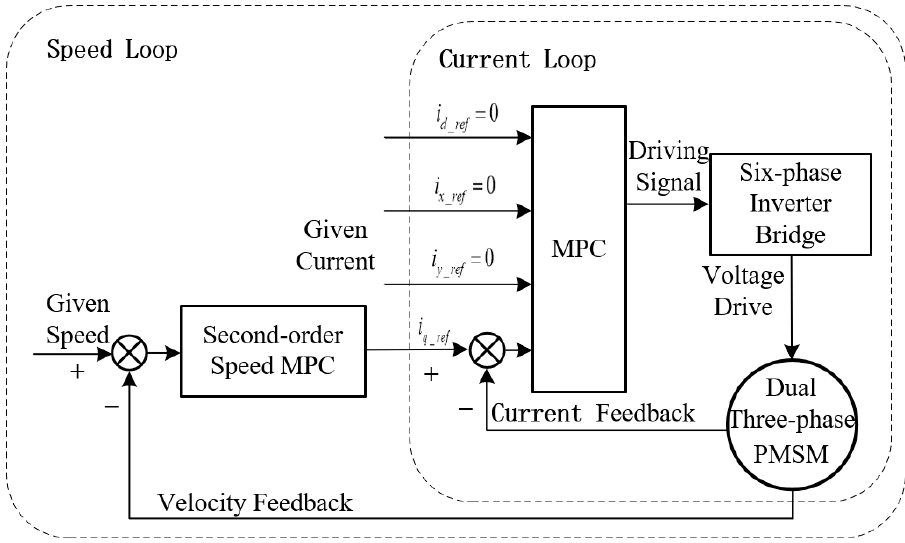
Figure 4. Dual second-order model predictive current control block diagram.